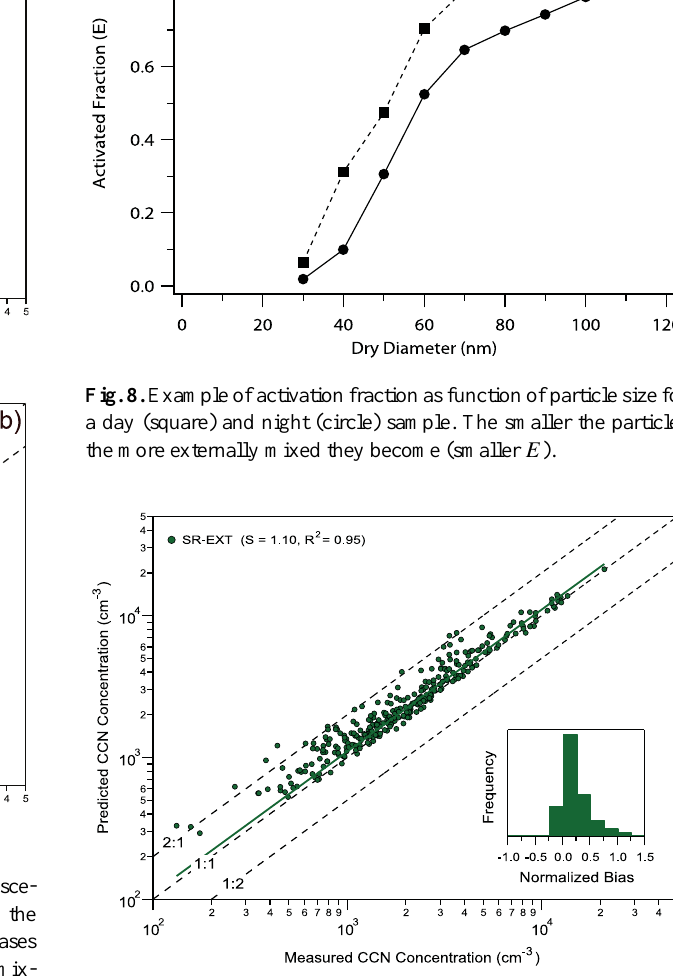
Fig. 9. CCN closure plot for the size-resolved external mixture (SR- EXT) scenario. Inset plot shows the observed frequency distribution of the normalized mean bias=( P i − O i )/ O i